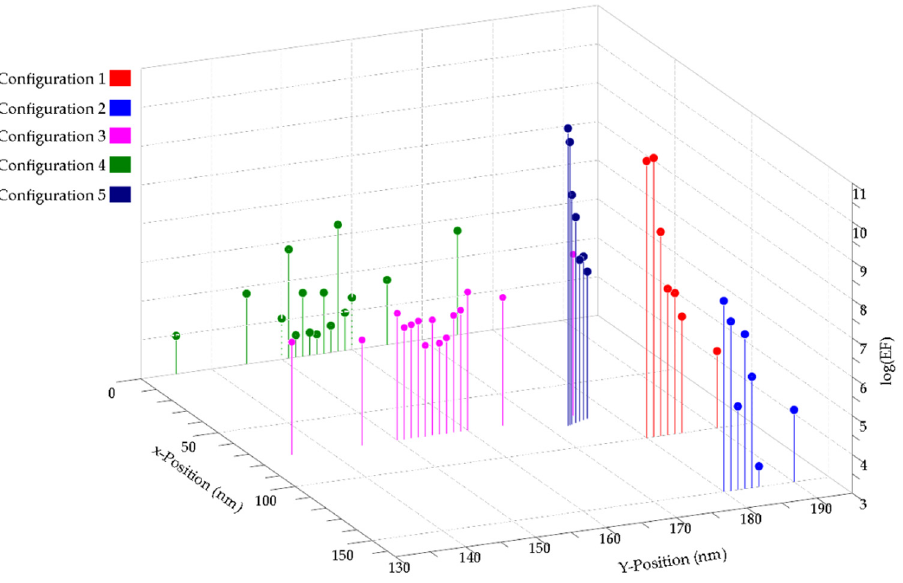
Figure 6. Summary of the Ag-NP-on-Au-NHA G SERS value variation for different positions along the z -axis for Configurations 1–5.